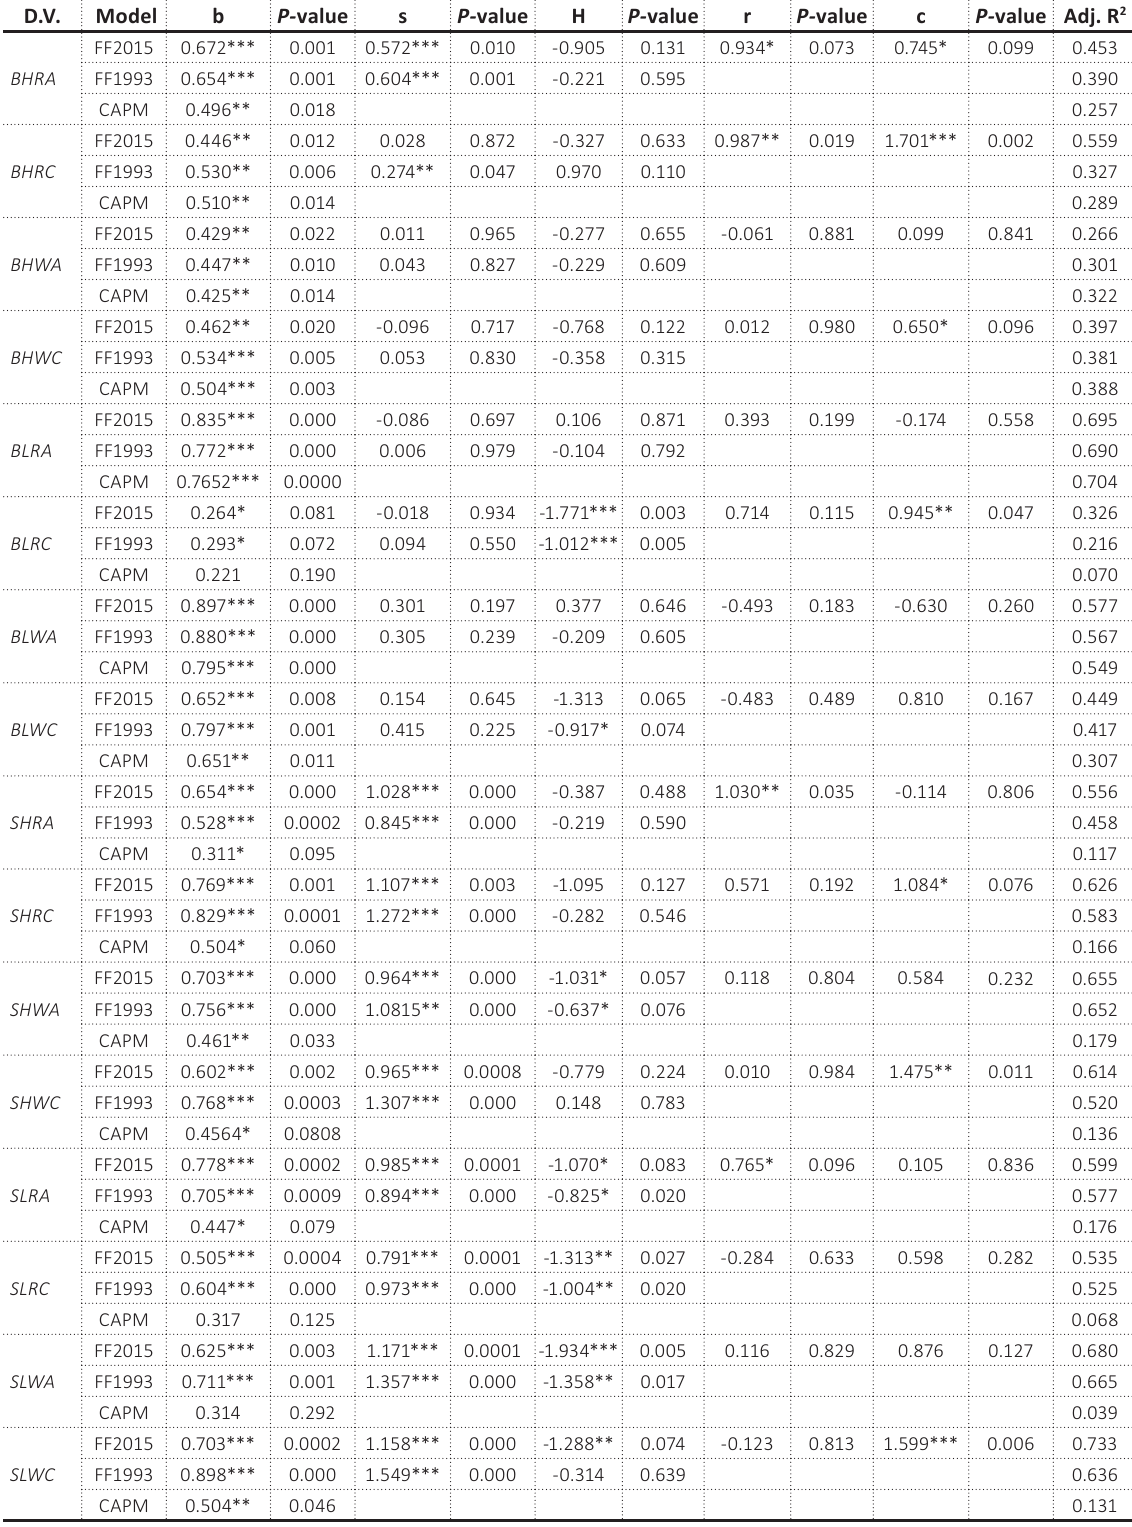
Table F1. Coefficients: 2x2 factors sort on Size and B/M, Size and OP, Size and Inv